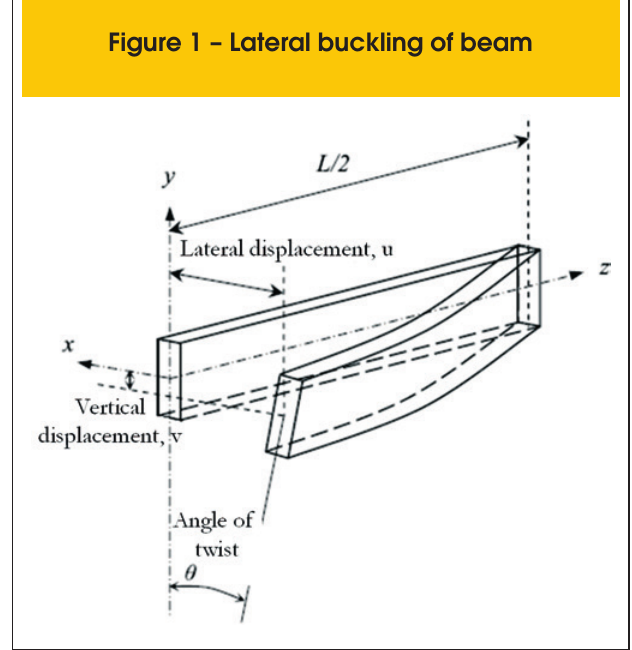
Figure 1 – Lateral buckling of